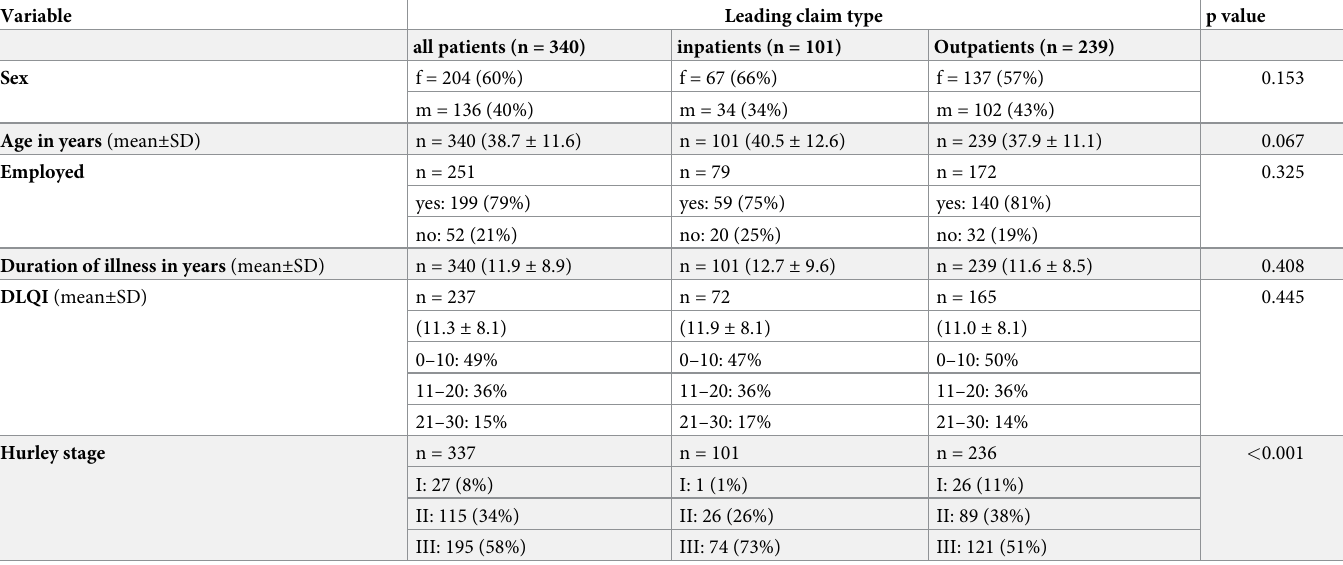
Table 1. Sociodemographic data and clinical characteristics of the study population.